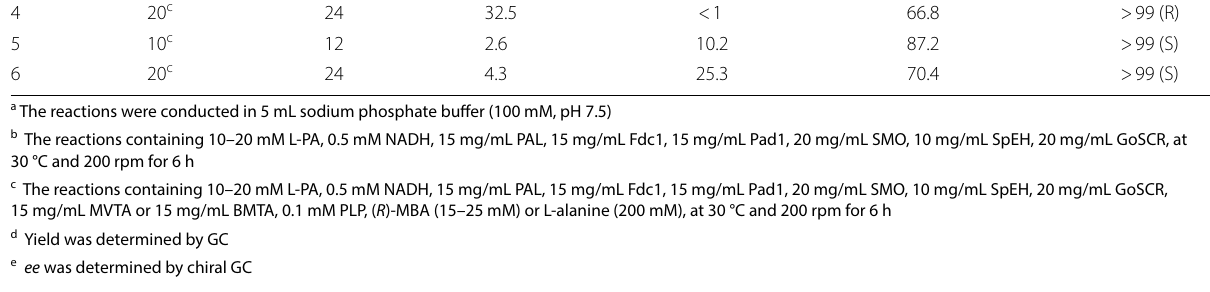
a The reactions were conducted in 5 mL sodium phosphate buffer (100 mM, pH 7.5)